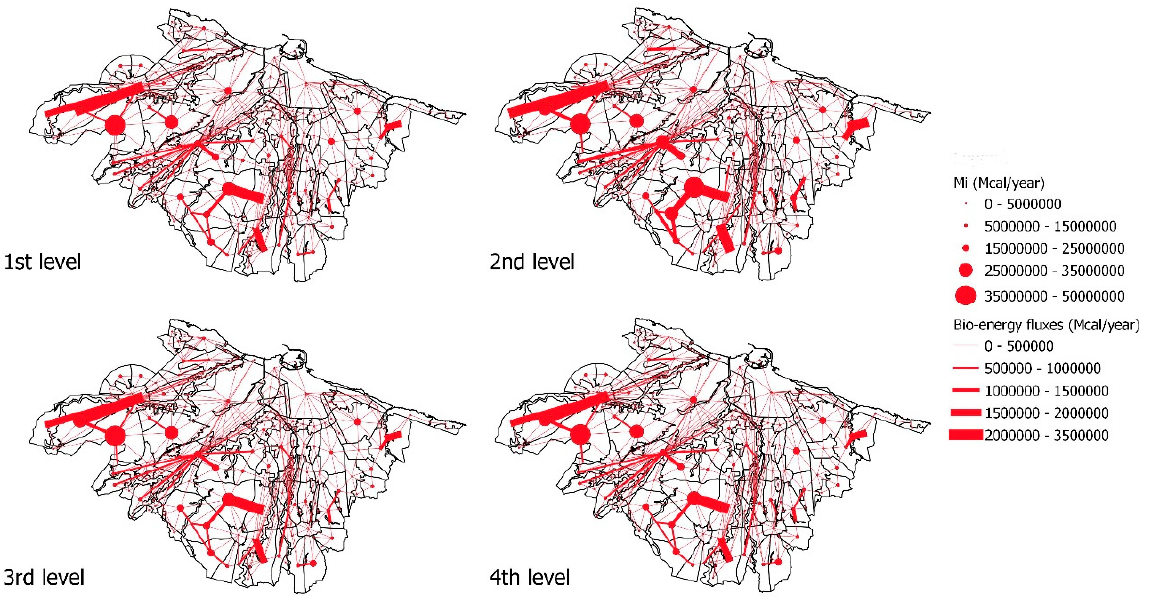
Figure 5. Bio-Energy Landscape Graph (BELG). Circles represent the bio-energy of each BELU and arcs describe the fluxes of bio-energy between adjacent BELUs.